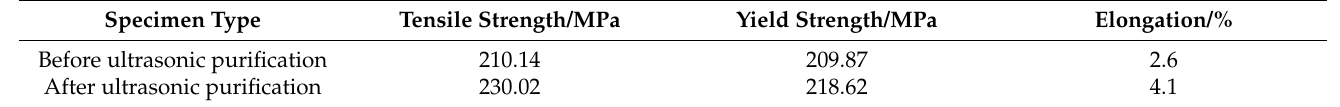
Table 4. Comparison of tensile mechanical properties of aluminum melt solidified samples in